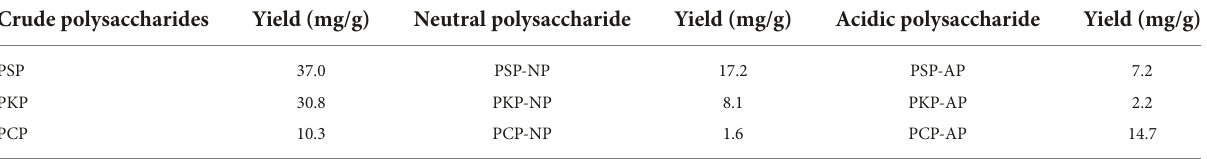
TABLE 3 The yield of crude polysaccharides and purified fractions from different species of Polygonati Rhizoma. Crude polysaccharides Yield (mg/g) Neutral polysaccharide Yield (mg/g) Acidic polysaccharide Yield (mg/g) PSP 37.0